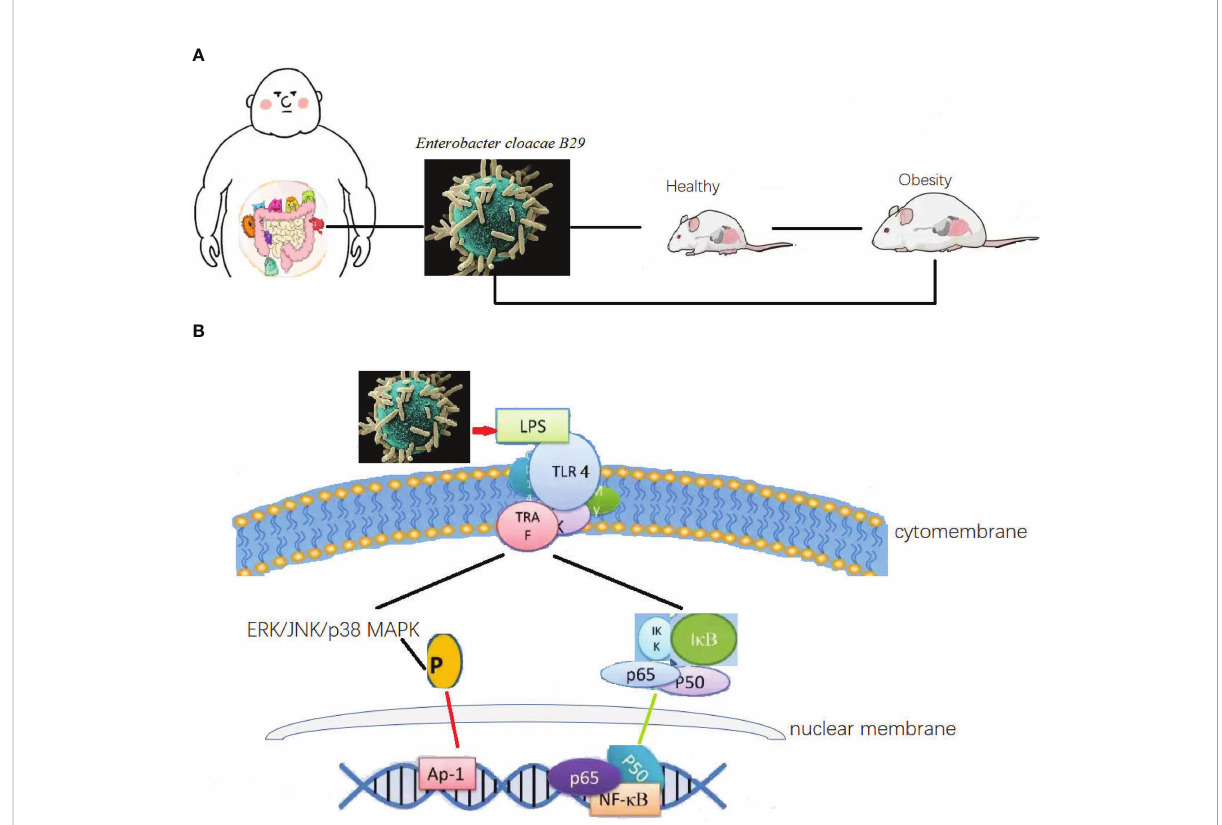
FIGURE 1 The differential bacteria in obesity and as a causation to obese. (A) Intestinal bacteria was both the cause and syndrome for the obesity. Causation relationship between the disease and organic bacteria. Microbiota transplanted from the obesity children to germ free mice caused the same syndromes. The strain of Enterobacter cloacae B29 was proved as the prime culprit to little fatties ’ children syndrome. Toxins such LPS produced through playing pleiotropic role one pathway was recognized by toll like receptor 4 to upstream signal pathway to regulate gut permeability, and control adipose tissue metabolism through mediating cannabinoid-driven adipogenesis, which accelerated the syndrome of obesity. (B) Then possible molecular signal pathway of Enterobacter cloacae B29 regulated the adipose tissue metabolism. The toxin produced by Enterobacter cloacae B29 can promote the syndrome. Toxins such LPS produced through playing pleiotropic role one pathway was recognized by toll like receptor 4 to upstream signal pathway to regulate gut permeability. The signaling pathways involved include the ERK/p38/JNK and nuclear transcription factor pathways were enrolled to control adipose tissue metabolism through mediating cannabinoid-driven adipogenesis, which accelerated the syndrome of